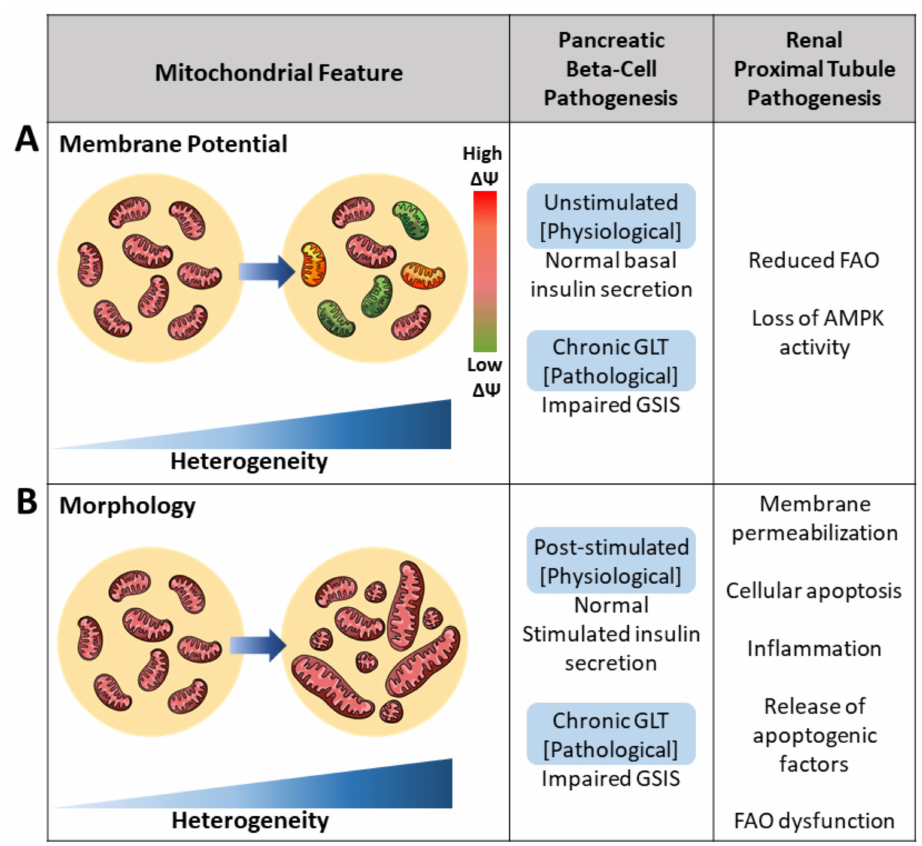
Figure 2. Pathogenesis of the pancreatic beta-cell and renal proximal tubule cell induced by increased mitochondrial heterogeneity. Mitochondrial heterogeneity under the pathological state, such as glucolipotoxicity (GLT), yields various functional readouts. ( A ) Increased mitochondrial membrane potential ( ∆Ψ ) heterogeneity has been associated with various metabolic defects in both the pancreatic beta-cell and renal proximal tubule cell. Intracellular heterogeneity is observed by an increase in differences in ∆Ψ . Reduced ∆Ψ is presented as green and increased ∆Ψ is presented as red. Mitochondria of normal ∆Ψ are presented as pink. ( B ) Architectural heterogeneity yields mitochondria varying from short to long mitochondrial lengths as a result of varying fusion and fission rates. Increased heterogeneity in mitochondrial morphology, specifically increased short mitochondria due to reduced fusion, is associated with reductions in impaired glucose-stimulated insulin secretion (GSIS) in pancreatic beta-cells and reductions in renal fatty acid oxidation